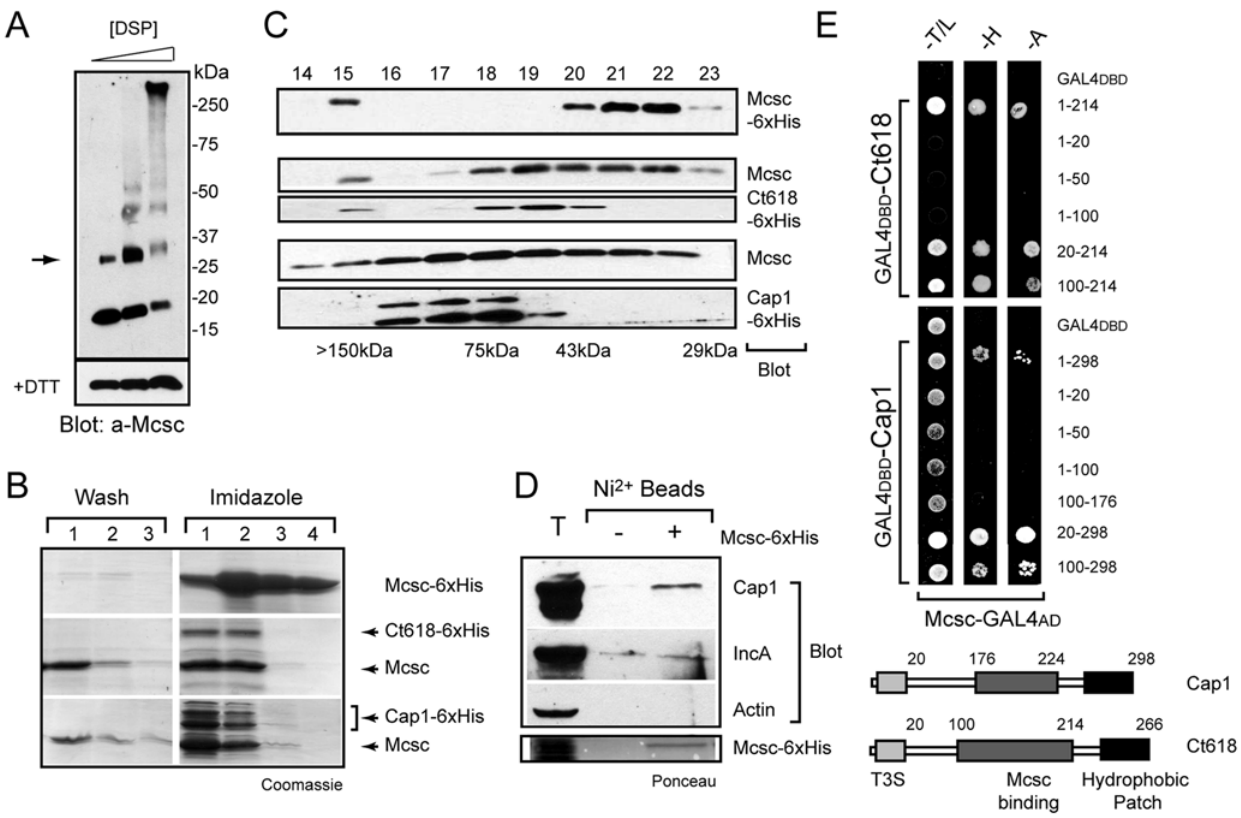
Figure 3. Ct260/Mcsc (Multiple cargo secretion chaperone) dimers bind to the inclusion membrane proteins Cap1 and Ct618. ( A ). Mcsc forms a dimer . Hexahistidine-tagged –Mcsc (Ct260) was treated with various concentrations of the reversible crosslinker DSP, resolved on a 4– 20% gradient gel and probed with Mcsc specific antibodies. Arrow marks the dimeric form of Mcsc, which was reduced to monomeric form after boiling in the presence of DTT. ( B–C ). Mcsc-Cap1 and Mcsc-Ct618 co-purify as complexes . ( B ). Lysates of E. coli expressing 6xHis-tagged Mcsc or co- expressing Mcsc and 6xHis-tagged Ct618 (aa1–189) or Cap1 (aa1–298) were incubated with Ni 2 + -NTA agarose beads. Bound proteins were eluted with 150 mM imidazole and detected by SDS PAGE and Coomassie staining. Mcsc co-purified with Ct618-6xHis and Cap1-6xHis on Ni 2 + beads. The numbers above the lanes represent fractions collected after incubation with wash buffer or elution buffers. Untagged Mcsc does not bind to the nickel columns non-specifically (Fig. 4E). ( C ). Proteins eluted from affinity columns were further fractionated by gel filtration chromatography. Mcsc eluted from the column at a size of , 34 kDa. Mcsc-Cap1 and Mcsc/Ct618 eluted as complexes of , 66 kDa and 54 kDa, respectively. The identity of all eluted proteins was confirmed by immunoblot analysis with anti Mcsc, Cap1 and hexahistidine tags. ( D ). Mcsc binds to endogenous Cap1 from infected cells . Lysate of infected HeLa cells were incubated with purified Mcsc dimers pre-bound to Ni 2 + -NTA agarose beads, and proteins were eluted with 150 mM imidazole. Cap1, but not IncA, preferentially co-eluted with Mcsc. Ponceau staining of nitrocellulose membrane indicate levels of Mcsc eluted from beads. ( E ). The central region of Ct618 and Cap1 mediate binding to Mcsc . The Mcsc binding domains of Ct618 and Cap1 were mapped by Y2H analysis. Positive interactions were assessed by activation of GAL4-dependent HIS3 and ADE2 reporter genes and growth in media lacking histidine (H) or adenine (A). Growth on media lacking tryptophan (T) and leucine (L) are shown as controls for maintenance of the Y2H vectors. Cartoon schematic shows Mcsc binding region maps adjacent to the large hydrophobic region at the COOH-terminus of these inclusion membrane proteins.